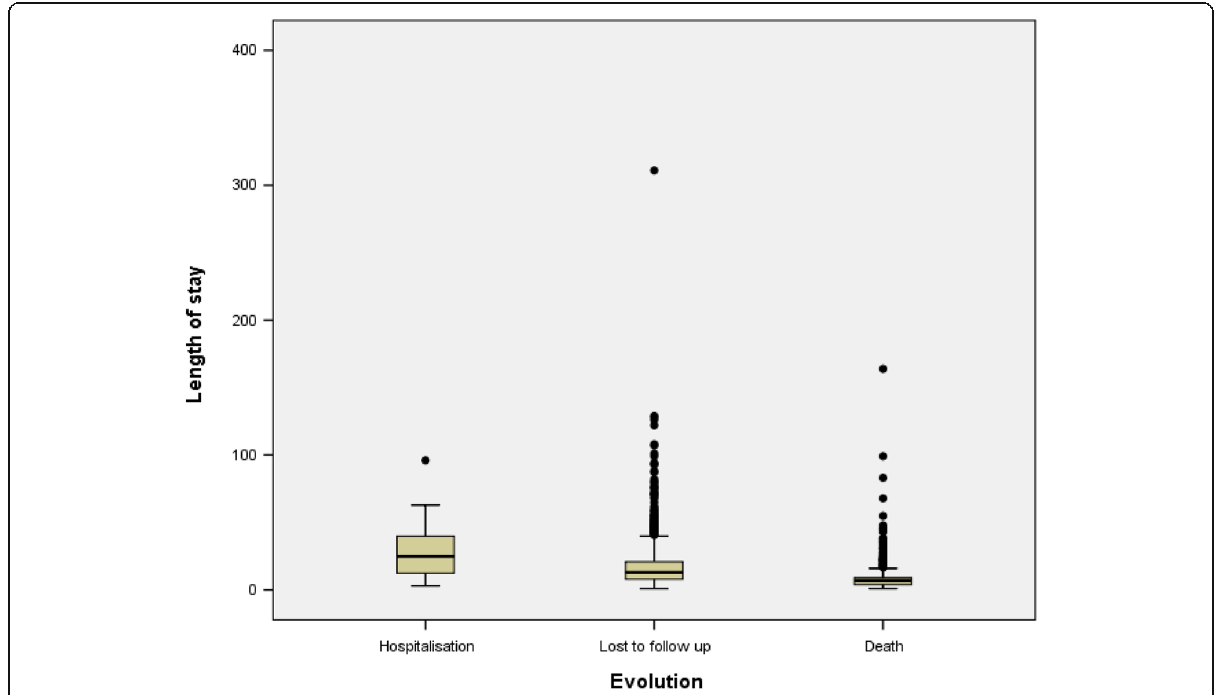
Fig. 1 Length of stay according to patients ’ evolution